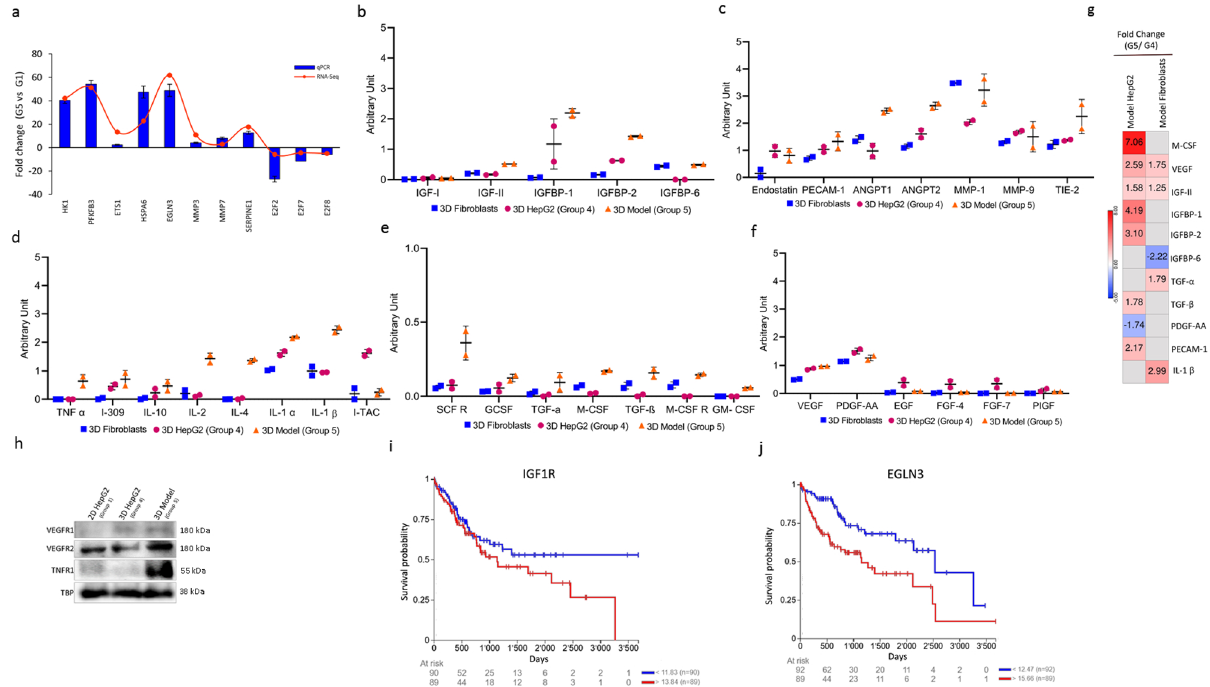
Figure 4. Confirmation studies using genomic, proteomic, and clinical analyses. ( a ) Validation by qPCR. RNA- Seq based expression was plotted against qPCR-based expression. qPCR data are represented as means of fold change ± SD. ( b – f ) levels of different secreted factors in 3D mono- and co-cultures analyzed by antibody arrays. Experimental scheme is outlined in Fig. S2 ( g ) fold change of expression of HepG2 and Fibroblasts before and after co-culture for markers shown in panels ( b – f ) based on RNA-seq data. ( h ) western blotting of total cell lysates of 2D or 3D HepG2 cultures. Uncropped blots are shown in Fig. S3. ( i , j ) Kaplan–Meier overall survival analysis in LIHC patients upon IGF1R and EGLN3 expression. Log-rank test calculated p-value from upper and lower quartile comparisons and gene expression of GDC TCGA LIHC primary tumor samples is presented (n =